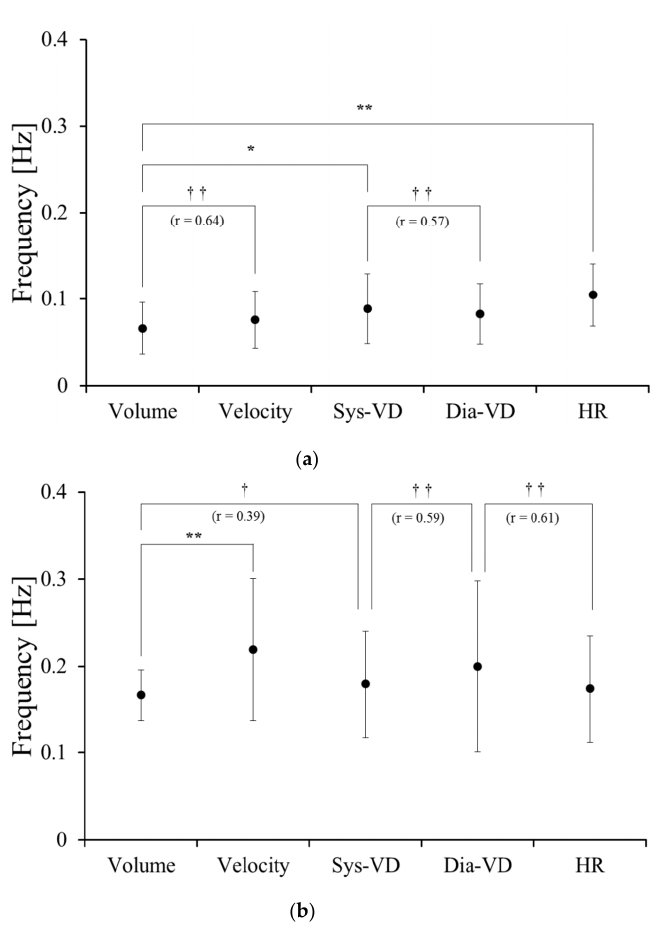
Figure 3. Comparison among the center frequency of blood flow volume (Volume), blood flow velocity (Velocity), systolic vessel diameter (Sys ‐ VD), diastolic vessel diameter (Dia ‐ VD) and heart rate (HR) in ( a ) the low ‐ frequency component (LF) and ( b ) the high ‐ frequency component (HF). Values represent the mean ± standard deviation (SD). Comparisons between parameters were performed using ANOVA with Dunnett’s post hoc tests (* p < 0.05; ** p < 0.01) and Pearson’s product ‐ moment correlation coefficient ( r : correlation coe ffi cient, † p < 0.05; †† p < 0.01). Statistical significance was assumed at p < 0.05.